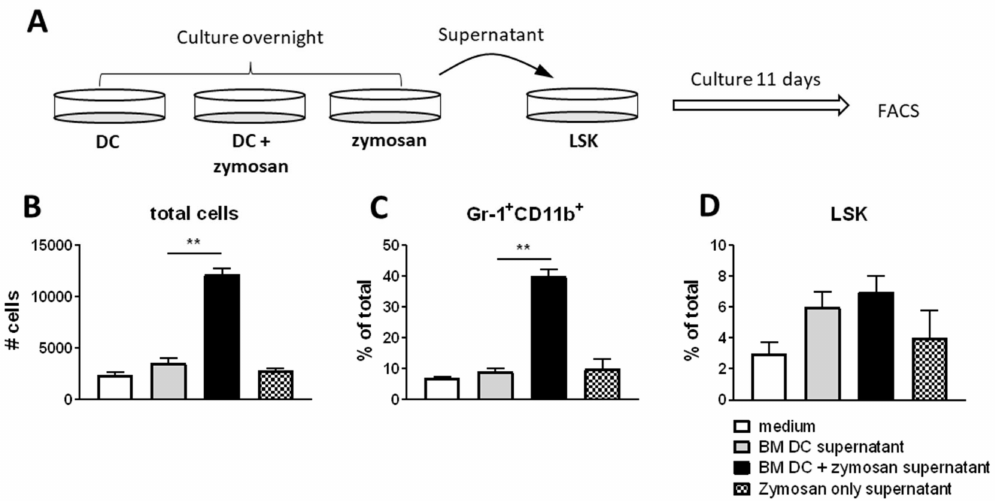
Figure 6. BM DCs promote neutrophil formation in a G-CSF dependent manner upon exposure to zymosan. ( A ) Experimental set-up of in vitro LSK cell cultures ( B ) Total number of cells, ( C ) per- centage of LSK, and ( D ) percentage of CD11b + GR-1 + neutrophil type cells after 11 days in vitro culture of LSK cells with supernatant of BM DCs and zymosan cocultures. Graphs depict mean ± SD of experimental duplicates and are representative of 4 independent experiments. (unpaired t -test). Gating strategy for LSK cells and neutrophil type cells after culture can be found in Supplementary Figure S6. Graphs depict mean ± SD of experimental duplicates and are representative of three independent experiments. (unpaired t -test). ** p <